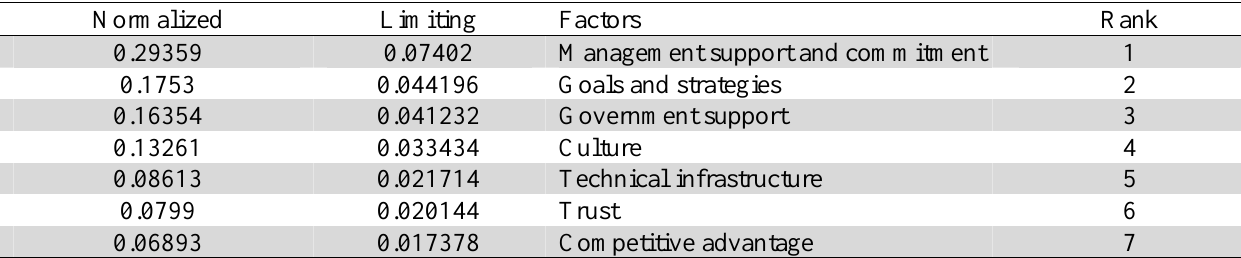
Priority of main factors